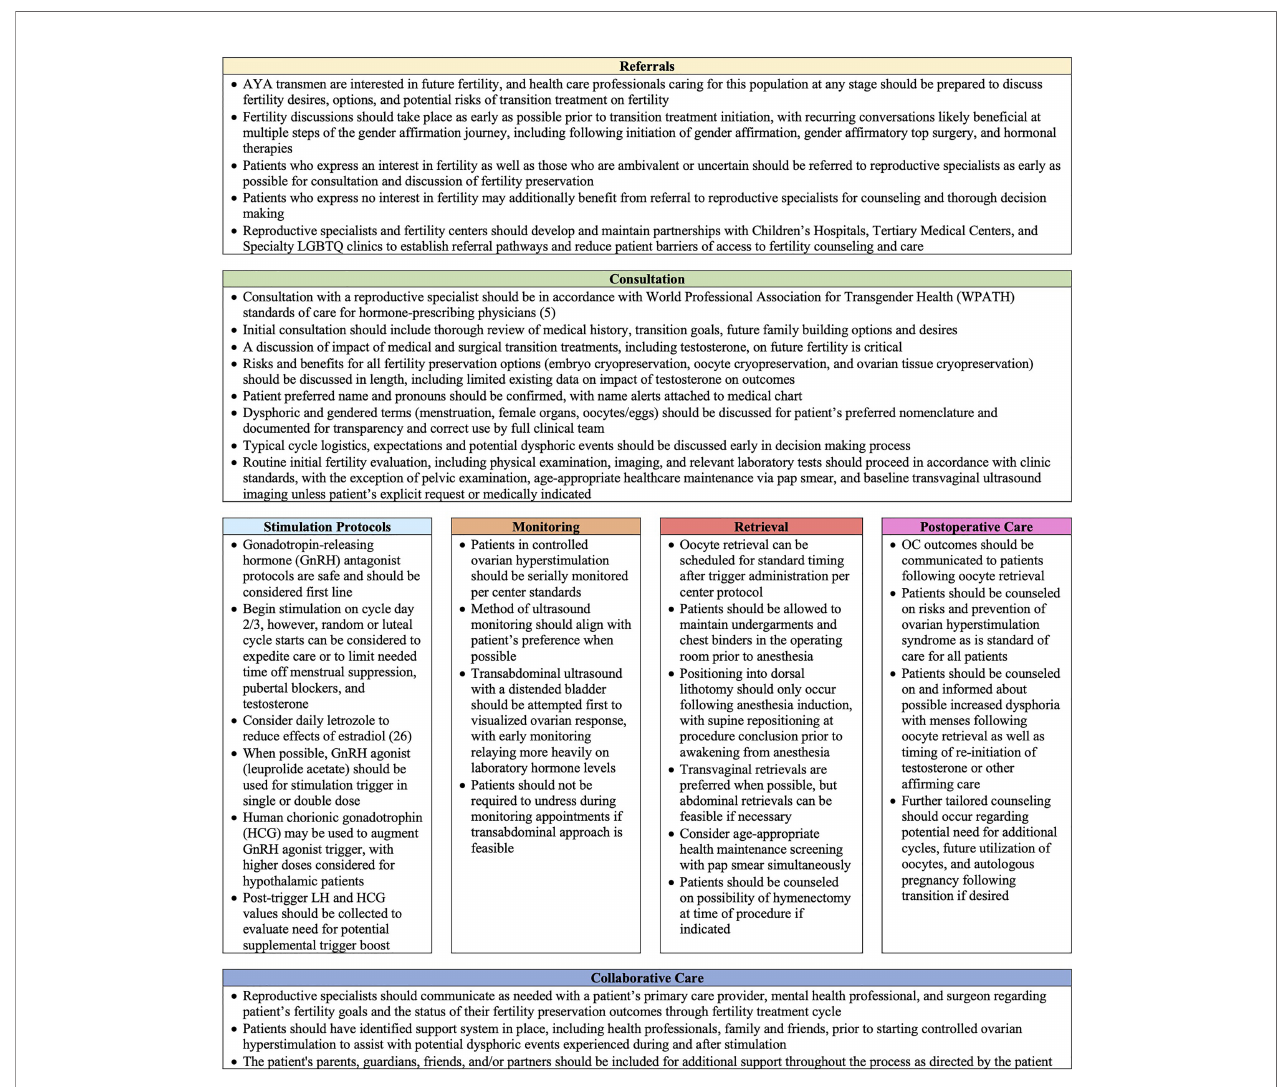
FIGURE 2 | Lessons Learned from Adolescent and Young Adult Transmen Undergoing Oocyte